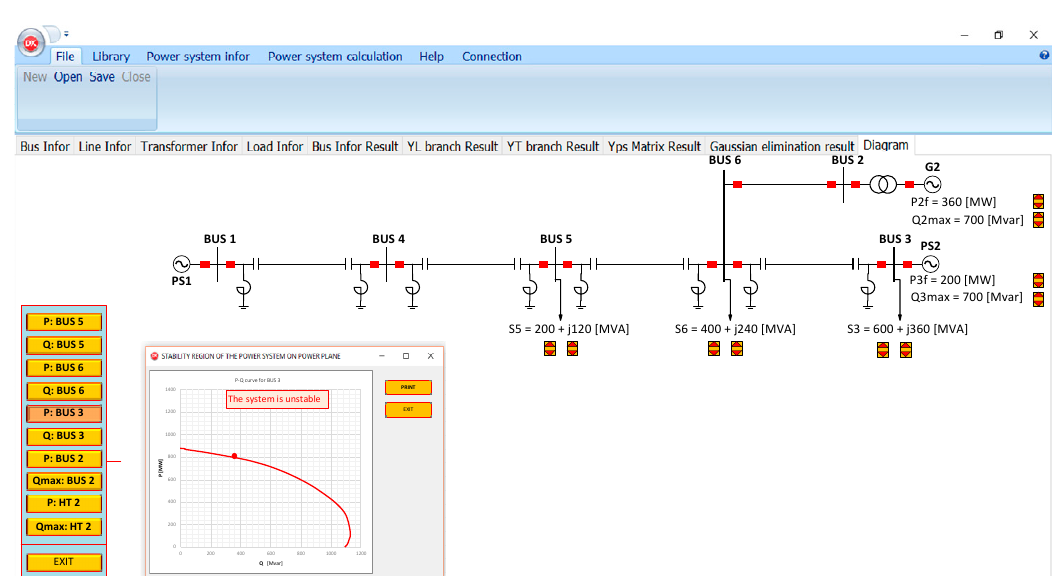
Figure 7. P-Q curve plotted for Bus 3 in a stable state.